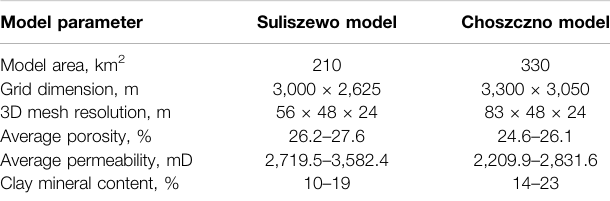
TABLE 1 | Details of the reservoir simulation model and parameters of reservoir horizon of the Lower Jurassic Komorowo Beds (Michna and Papiernik, 2012; Lubo ń , 2021).